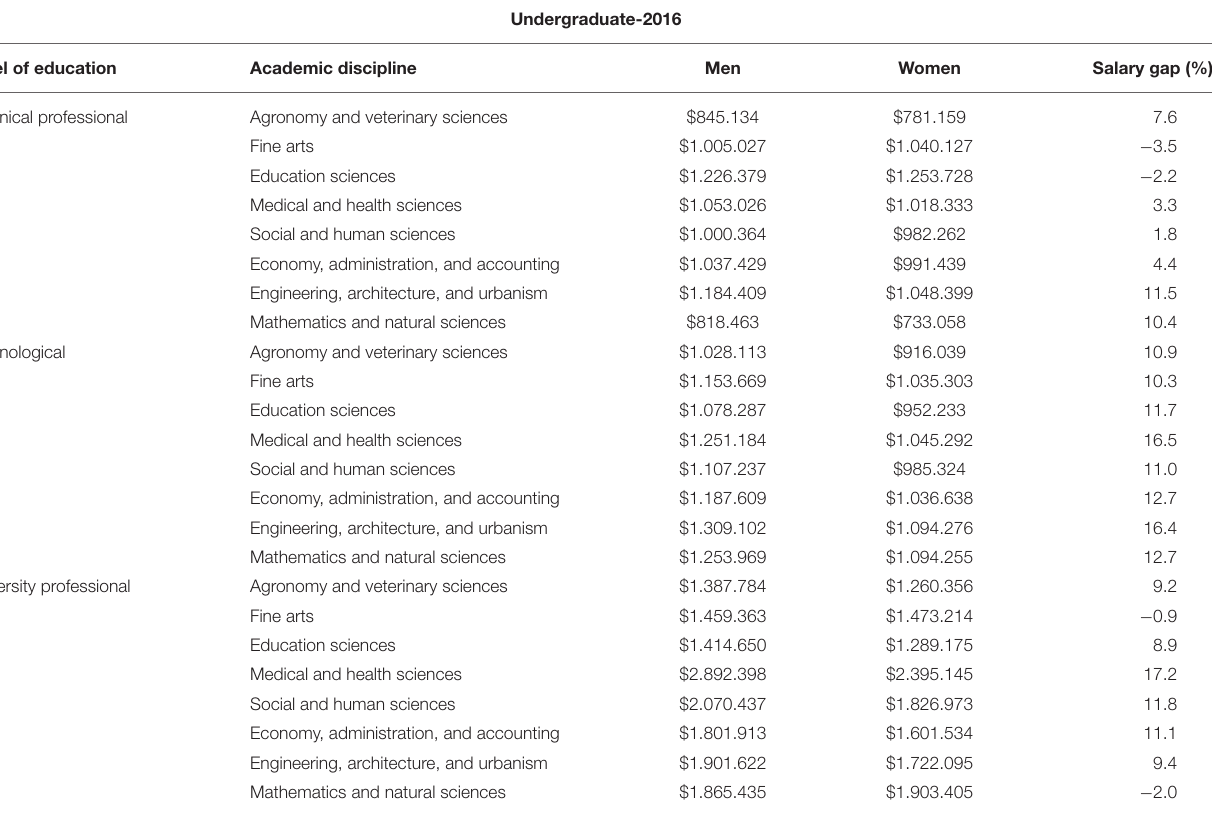
TABLE 3 | Salaries in 2016 of graduates from undergraduate programs in 2015 at higher education institutions in Colombia, divided by gender and academic